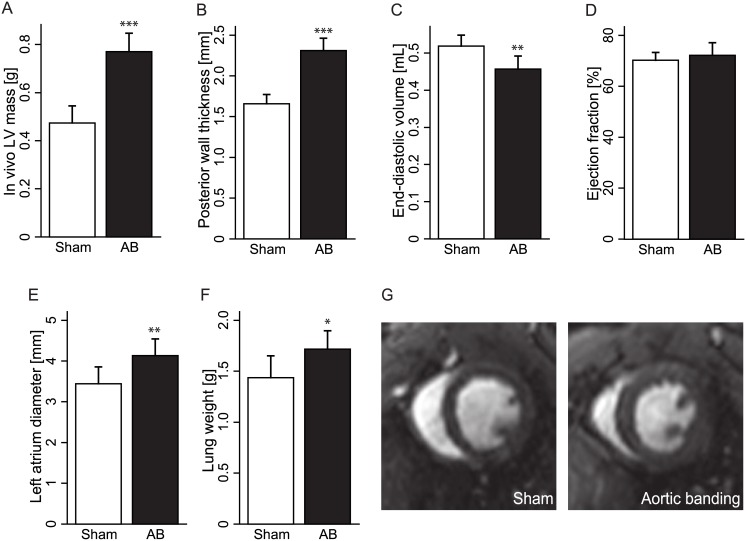
Animal characteristics 6 weeks after aortic banding (AB) or sham procedure.(A) In vivo left ventricular (LV) mass. (B) Posterior wall thickness in diastole. (C) End-diastolic volume. (D) Ejection fraction. (E) Left atrium diameter. (F) Ex vivo lung weight. (G) Representative cardiovascular magnetic resonance images of concentric hypertrophy in a sham (left) and aortic banding (right) rat. Values are presented as mean ± standard deviation. * indicate p<0.05, ** indicate p<0.01, *** indicate p<0.001 compared to sham.